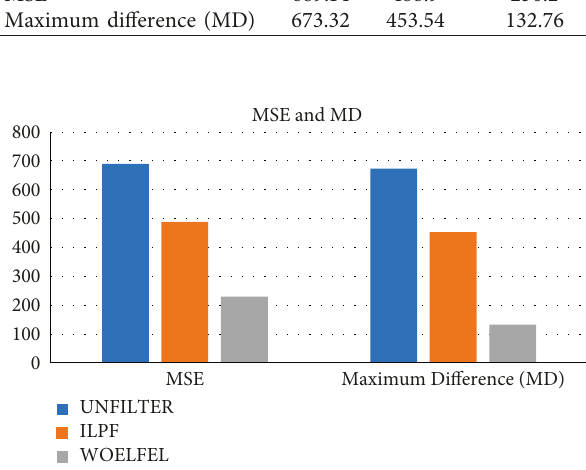
Figure 16: Comparison plot for MSE and MD